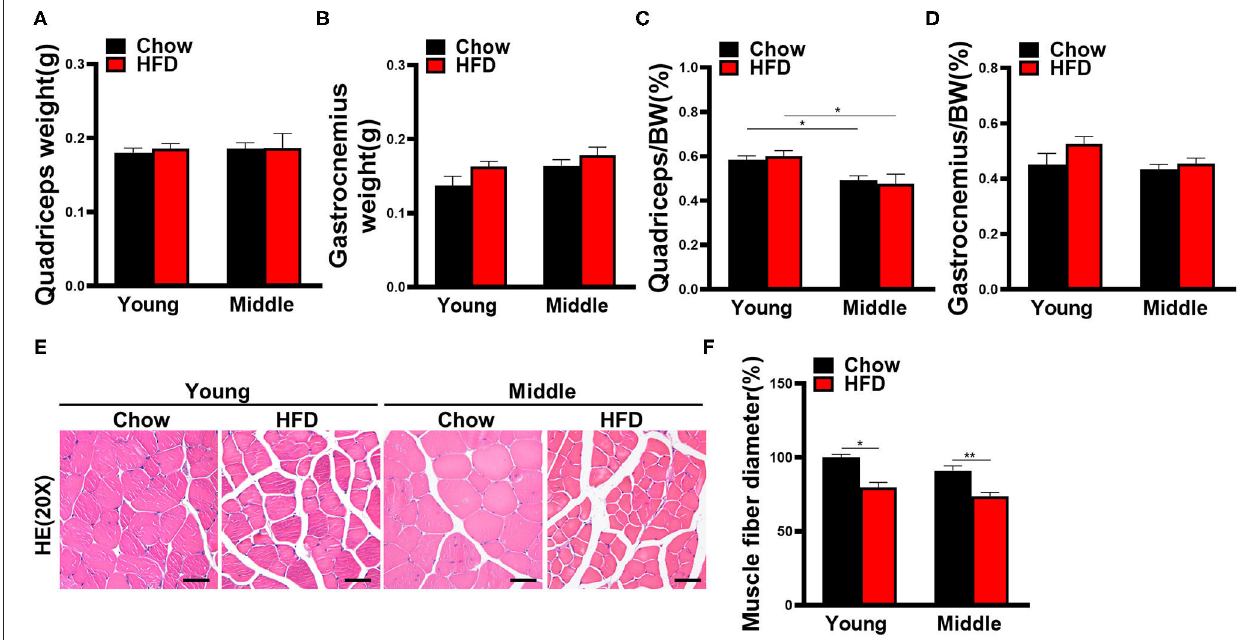
FIGURE 4 | Muscle weight and histological changes of mice fed with HFD for 20 weeks. (A) Quadriceps and (B) gastrocnemius muscle weight are measured ( n = 6–10). (C) Quadriceps weight and (D) gastrocnemius weight to body weight ratio are calculated ( n = 6–10). (E) Representative hematoxylin and eosin staining pictures of quadriceps in mice ( n = 5–10) are shown (scale bar, 50 µ m). (F) Average myofiber diameters were quantified ( n = 5–10). The data are presented as the mean ± SEM, unpaired two-tailed Student’s t -test. * P < 0.05, ** P <